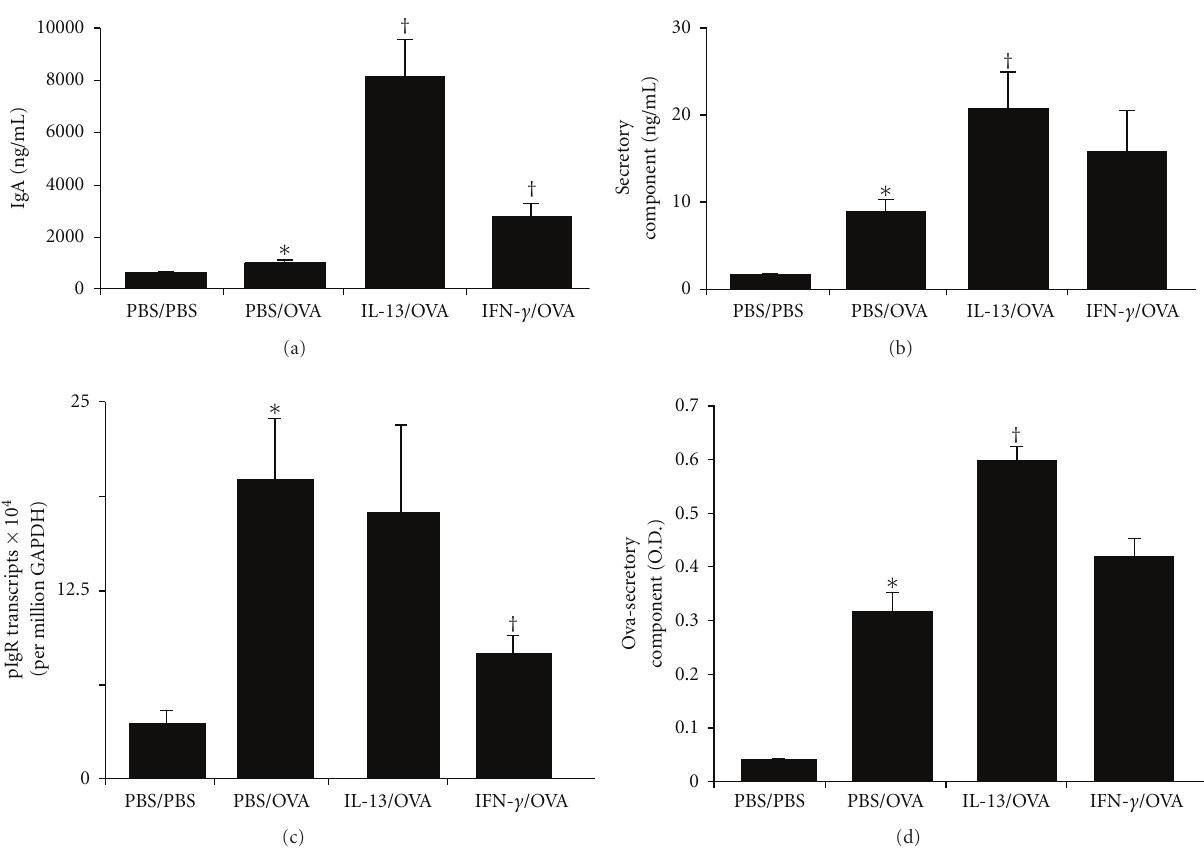
Figure 3: E ff ects of IL-13 and IFN- γ on SIgA. Levels of IgA in BALF (a), SC in BALF (b), whole lung pIgR transcripts (c) and OVA-bound SC in BALF (d) from PBS/PBS, PBS/OVA, IL-13/OVA and IFN- γ /OVA groups of mice. ∗ P -value ≤ . 05 versus PBS/PBS. † P -value ≤ . 05 versus PBS/OVA.